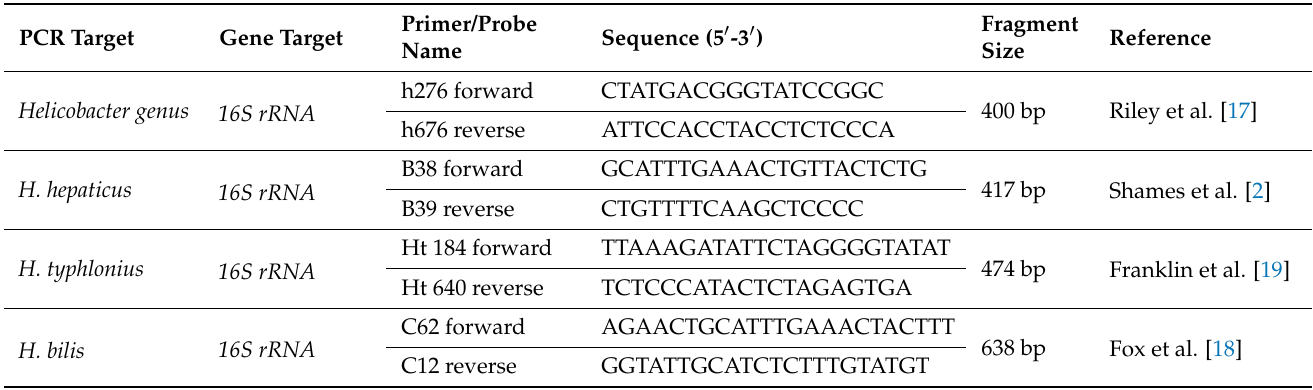
Table 1. Helicobacter genus- and species-specific primers in conventional PCR and in the Helicobacter multiplex DNA finder.